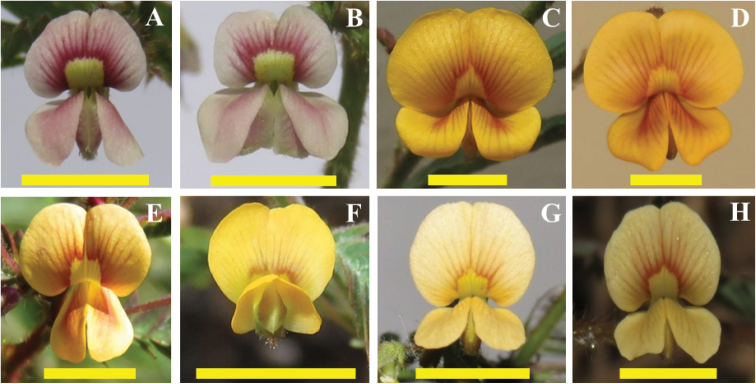
Floral morphotypes of taxa of the series Americanae. A, BAeschynomene
americanaCA.
americana
var.
flabellataDA.
americana
var.
glandulosaEAeschynomene
sp.
prope
americanaFA.
villosa
var.
villosaGA.
villosa
var.
longifoliaHAeschynomene
sp.
prope
villosa. Scale bars: 5 mm.